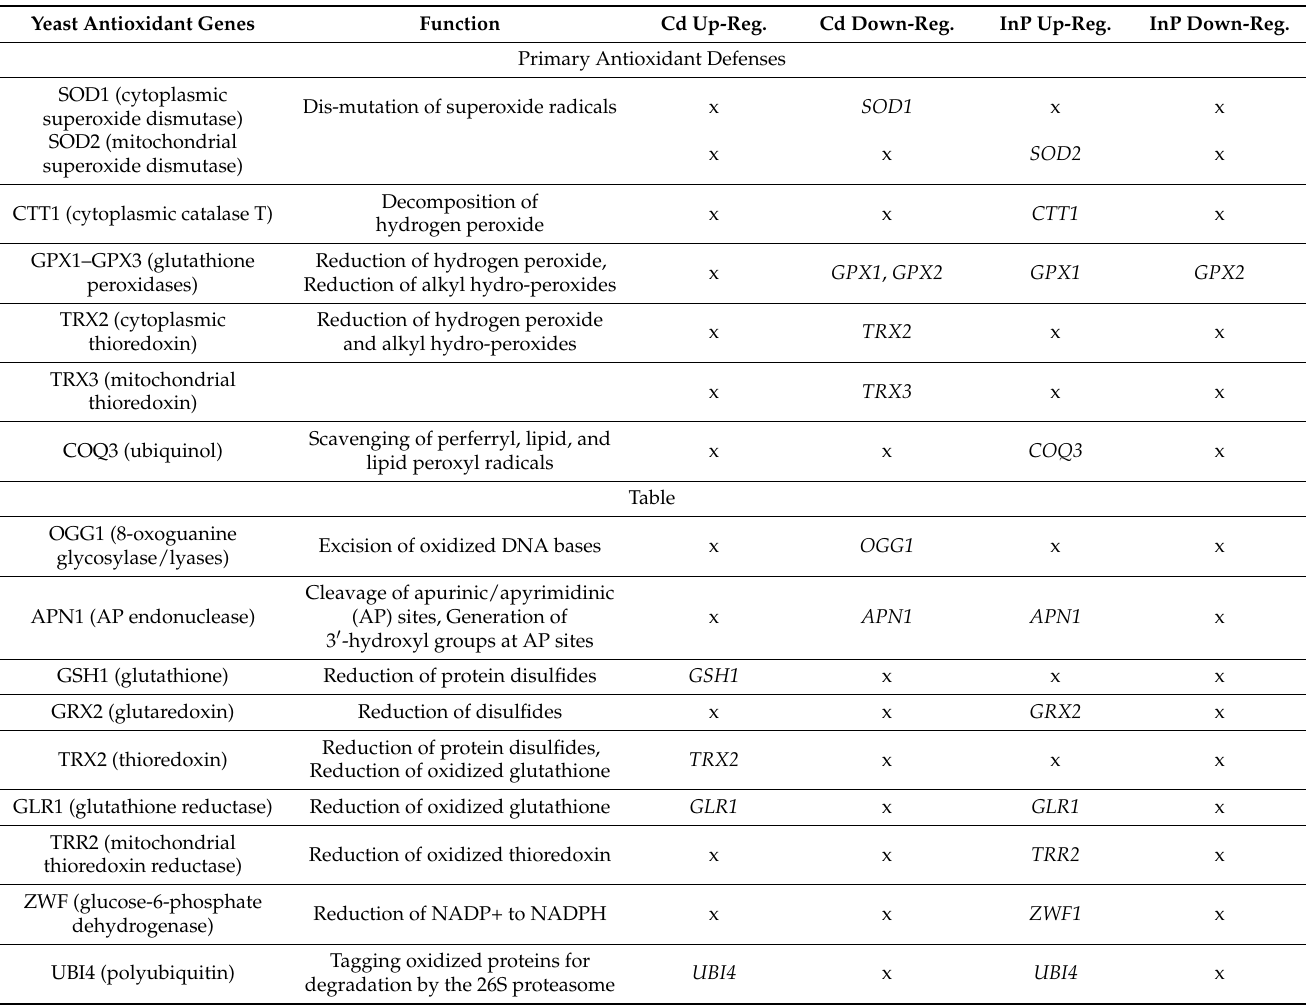
Tagging oxidized proteins for degradation by the 26S proteasome We quantified ROS levels (superoxide and peroxynitrite) in samples treated with CdSe/ZnS and InP/ZnS QDs at 10 and 100 µ g/mL, respectively (Figure 4). The cells were cultured for six hours with the nanomaterials, then allowed to grow for 2 h with DHE (dihydroethidium) and DHR-123 (dihydrorhodamine-123) prior to measuring the oxidized DHE and DHR fluorescent byproducts, which indicate levels of superoxide and peroxynitrite, respectively (Figure 4). No significant changes in ROS levels were observed in yeast treated with 10 µ g/mL CdSe/ZnS or InP/ZnS (Figure 4E,J). In cells dyed with DHE and treated with 100 µ g/mL CdSe/ZnS, we observed a significant increase in superoxide levels (Figure 4C,E). In cells dyed with DHE and treated with 100 µ g/mL InP/ZnS, we observed a significant decrease in superoxide levels (Figure 4D,E). In cells treated with DHR123, we observed a significant increase in peroxynitrite levels in those exposed to 100 µ g/mL CdSe/ZnS QDs (Figure 4H,J) and a significant decrease in cells exposed to 100 µ g/mL InP/ZnS QDs (Figure 4I,J). This suggests that both QDs have a unique effect on the generation of ROS in yeast and do not significantly affect ROS levels at concentrations lower than 10 µ